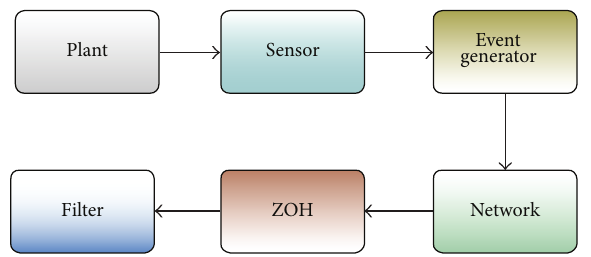
Figure 1: The structure of an event triggered filter design